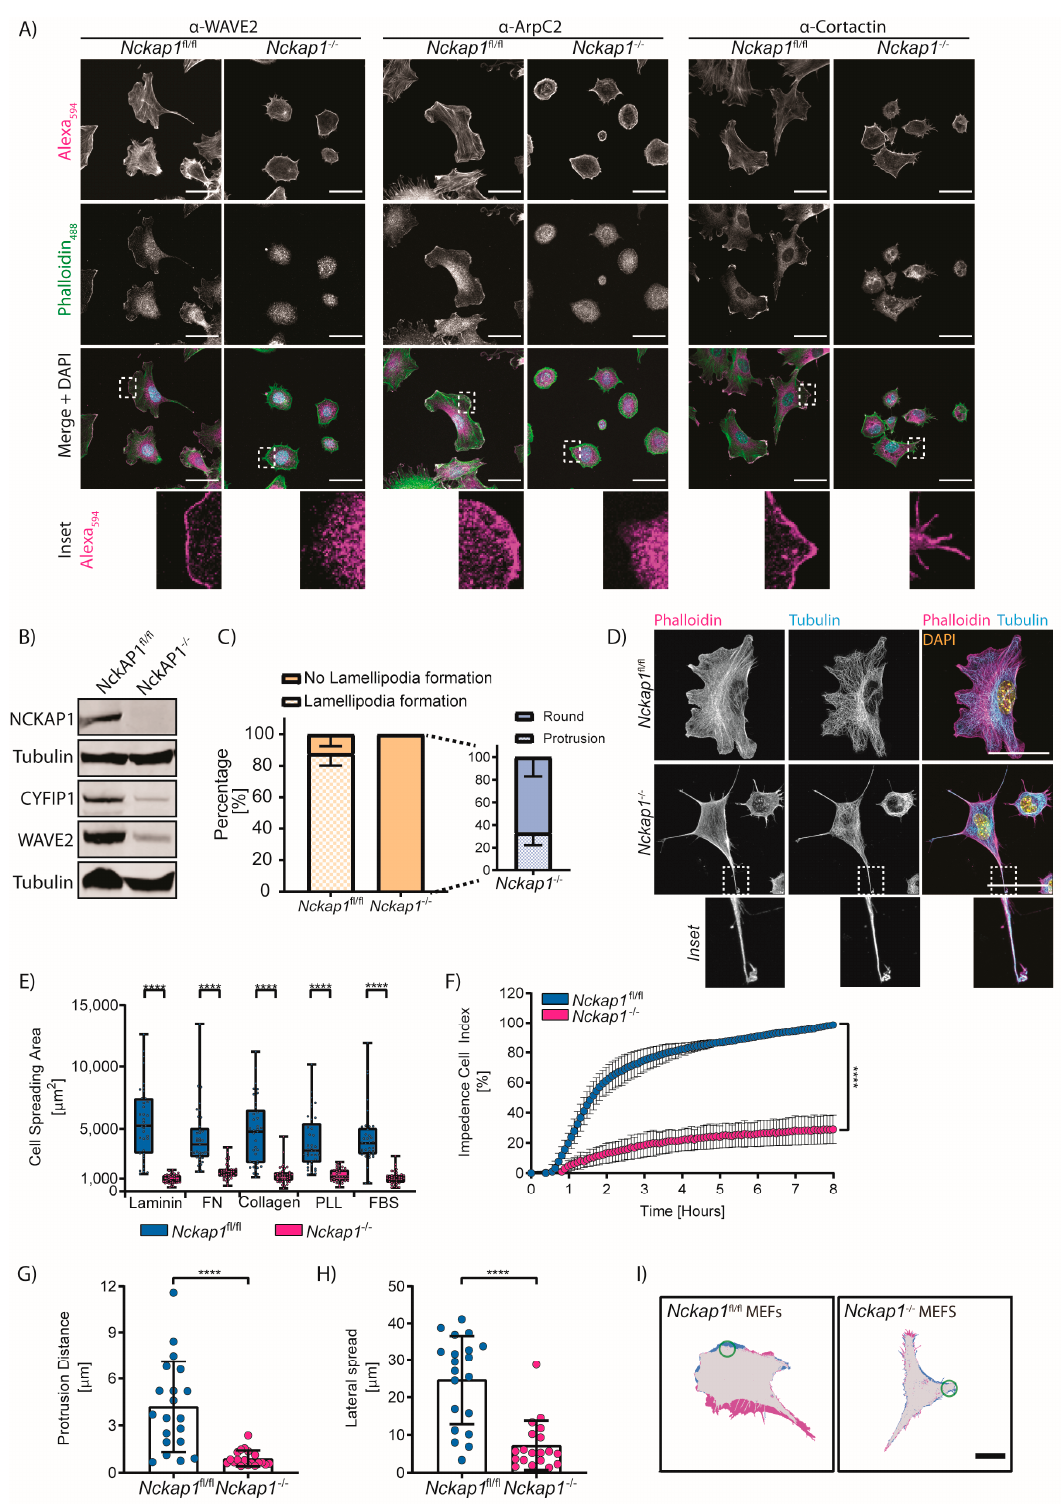
Figure 1. Effects on the lamellipodia in Nckap1 KO cells. ( A ) Immunofluorescence analysis of lamellipodia components (WAVE2, ArpC2 or Cortactin) in Nckap1 MEFs treated with either DMSO (control) or OHT (knockout). The actin cytoskeleton is shown by the phalloidin stain (green). The protein of interest is shown in magenta and an inset below showing the leading edge localisation of the protein of interest that is absent in the Nckap1 KO cells. Scale bar = 50 μ m. ( B ) Representative Western blots showing the loss of NCKAP1 and a significant down-regulation of other WRC components, WAVE2 and Cyfip1. Tubulin shown below protein tested relates to the loading control.